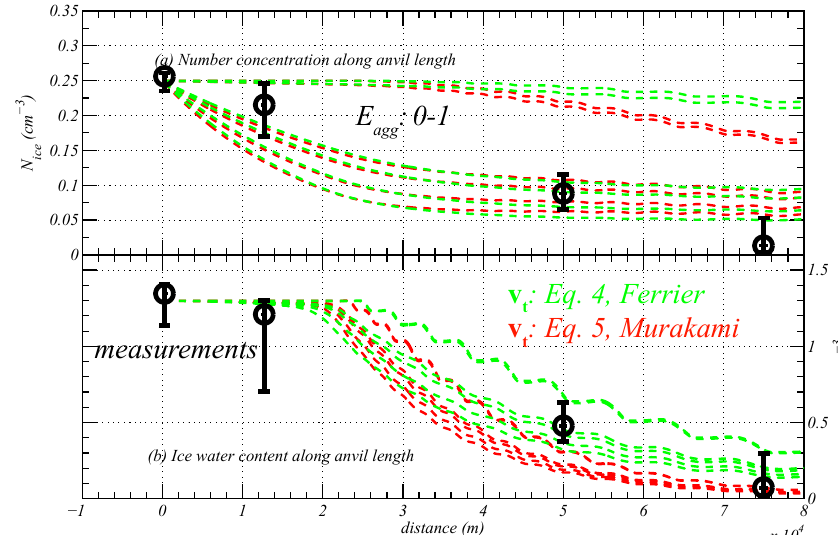
Fig. 14. (a) The crystal number concentration (cm − 3 ) observed with the CAPS-CIP instrument (black circles with error bars) as a function of distance downwind of the first leg (away from the storm) (b) The IWC (gm − 3 ) inferred from the CAPS-CIP instrument (black circles with error bars) as a function of distance from the main storm. Note that the green dashed lines are sampled from model simulations, that use the terminal velocity relation in Eq. (6), with different values of the E agg at the level of the flight tracks described in Sect. 3. The red dashed lines are the same but using the terminal velocity relation in Eq. ( 5). The model runs having the highest number concentrations and ice water contents at the end of the simulation are the ones having the lowest value of E agg = [ 0 . 00 , 0 . 02 , 0 . 50 , 0 . 60 , 0 . 80 , 1 . 00 ] and vice-versa.